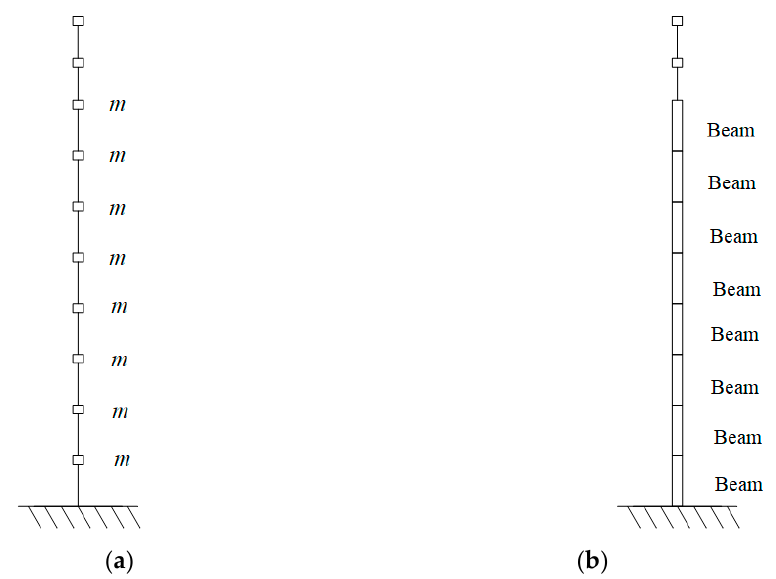
Figure 7. Schematic of the two BEMs of the two VAWTs: ( a ) the mass of the mast is assigned at nodes of beam elements; and ( b ) the mass of the mast is assigned on beam elements.